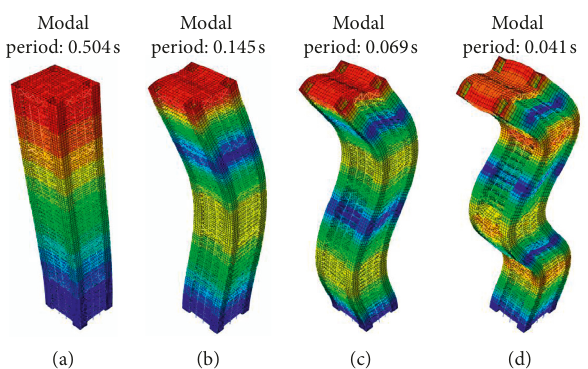
Figure 4: Mode shape and modal periods from the FE analysis: (a) first mode, (b) second mode, (c) third mode, and (d) fourth